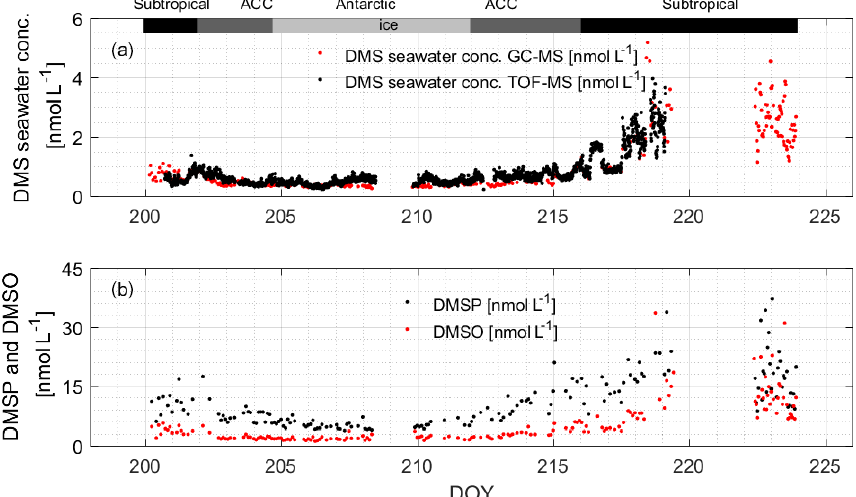
Figure 4. (a) Measured DMS concentrations in seawater using both instruments; (b) measured DMSP and DMSO concentrations in the sea surface using the GC–MS system. The bars across the top of the figure denote the different hydrographic regions discussed throughout the text.